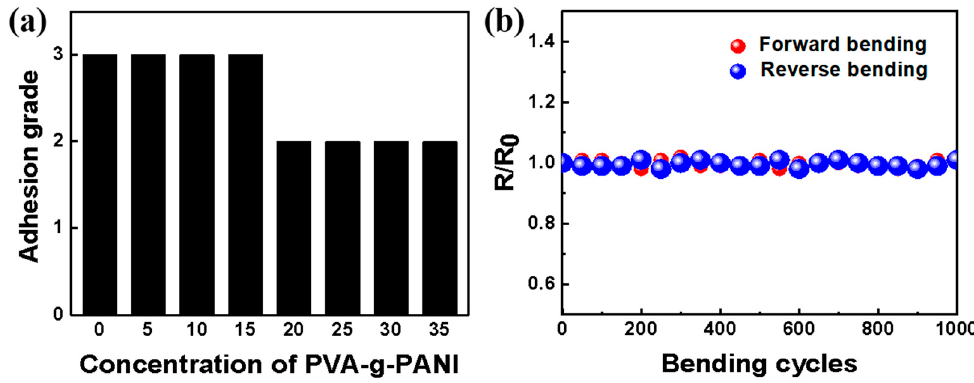
Figure 8. ( a ) Adhesion grade of the graphene/PVA-g-PANI ink on the BOPP substrate; ( b ) bending stability of the graphene/PVA-g-PANI film.